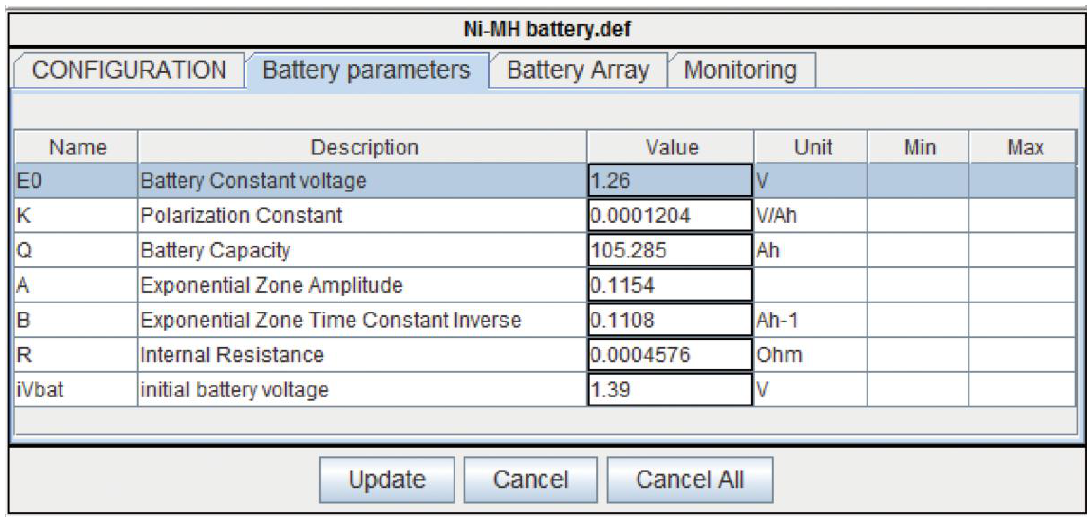
Figure 5. Battery model parameter configuration